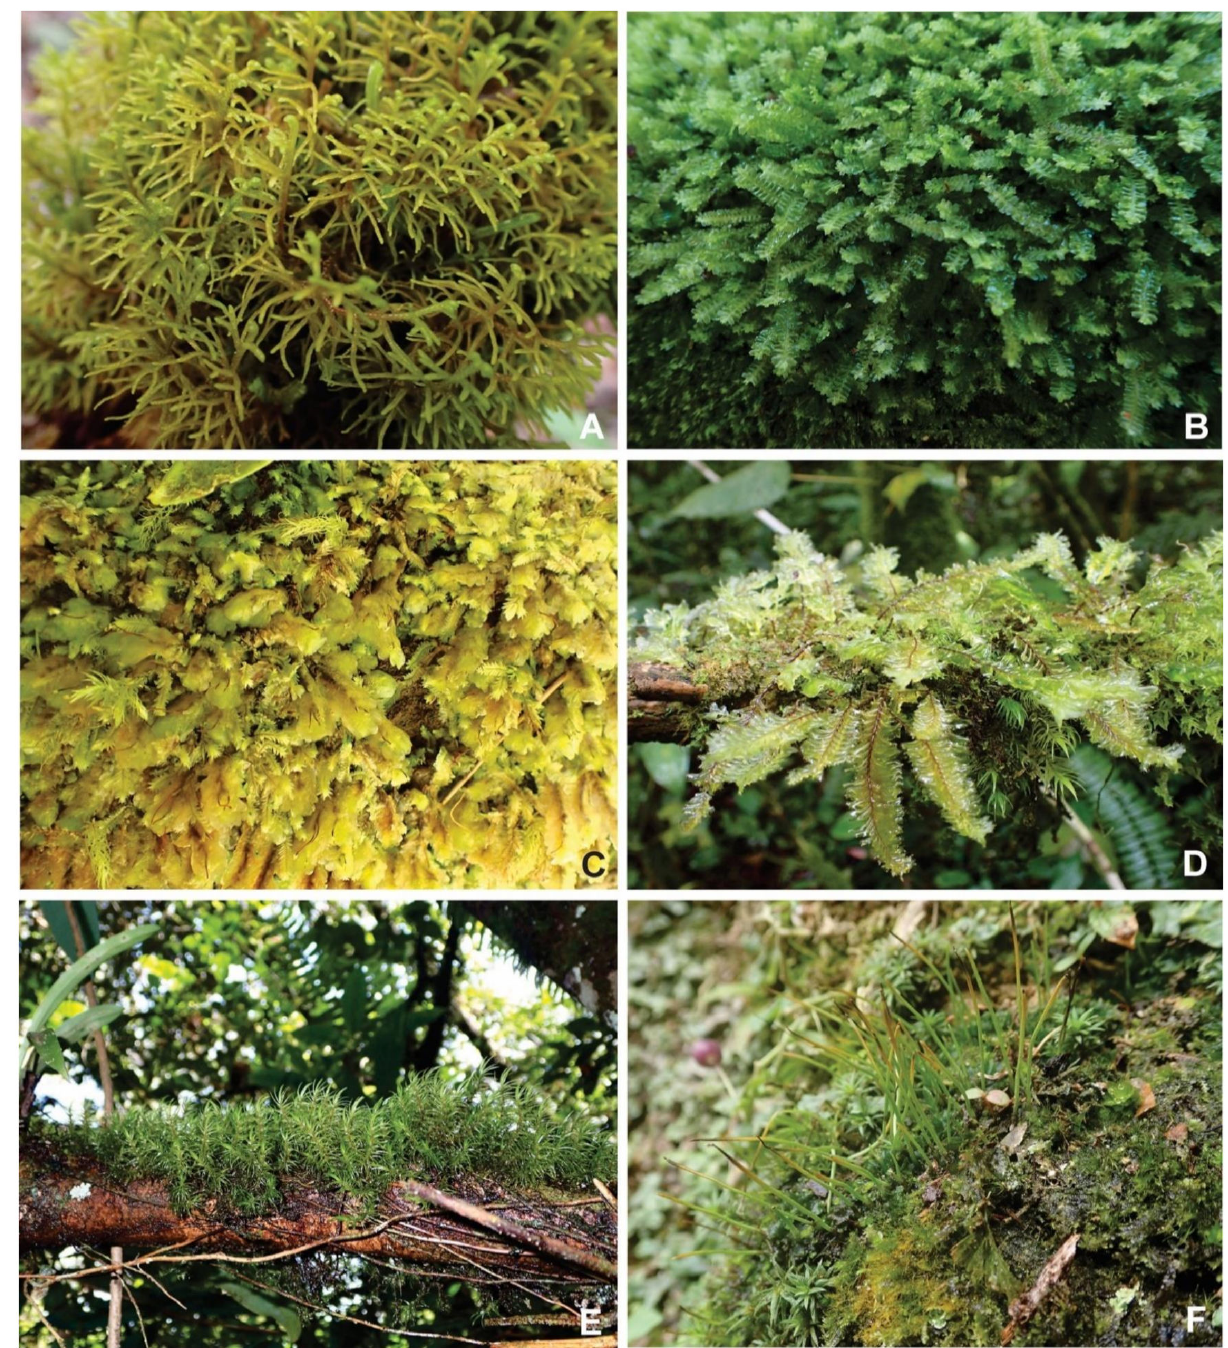
Figure 3. Bryophyte species and their habit from Cameron Highlands. ( A ) Mastigophora diclados (F. Weber) Nees. ( B ) Heteroscyphus coalitus (Hook.) Schiffn. ( C ) Distichophyllum mittenii Bosch and Sande Lac. ( D ) Plagiochila bantamensis Dumort. ( E ) Dicranoloma braunii (Müll. Hal.) Paris. ( F ) Anthoceros angustus